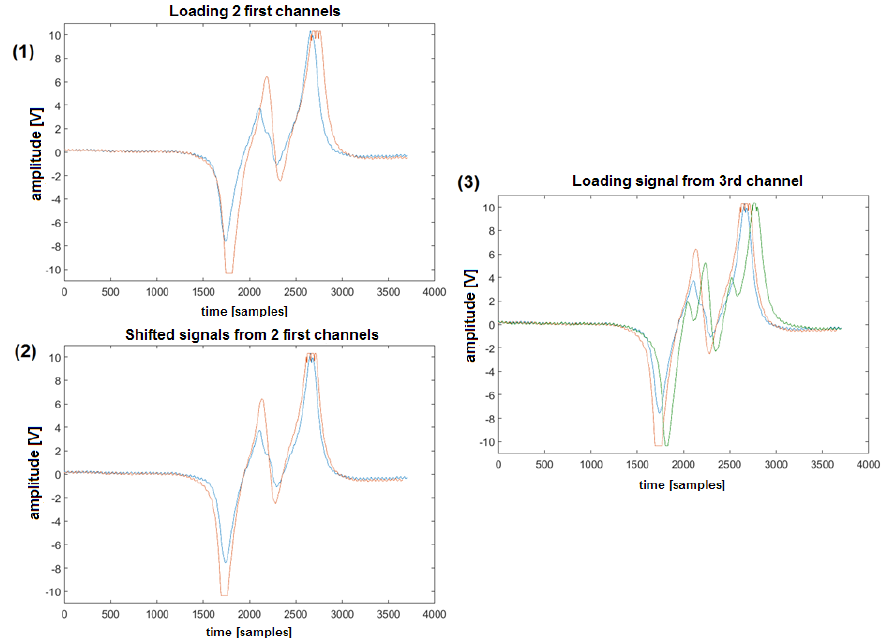
Figure 11. First three steps presented for manual channel